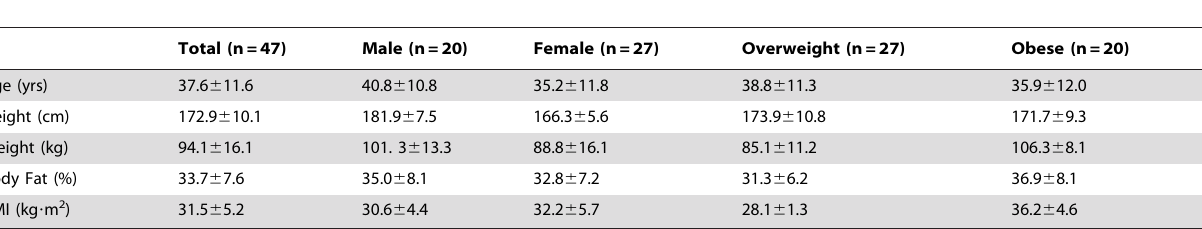
Table 1. Descriptive Statistics of all subjects, male, female, overweight and obese subjects, classified by BMI (Mean 6